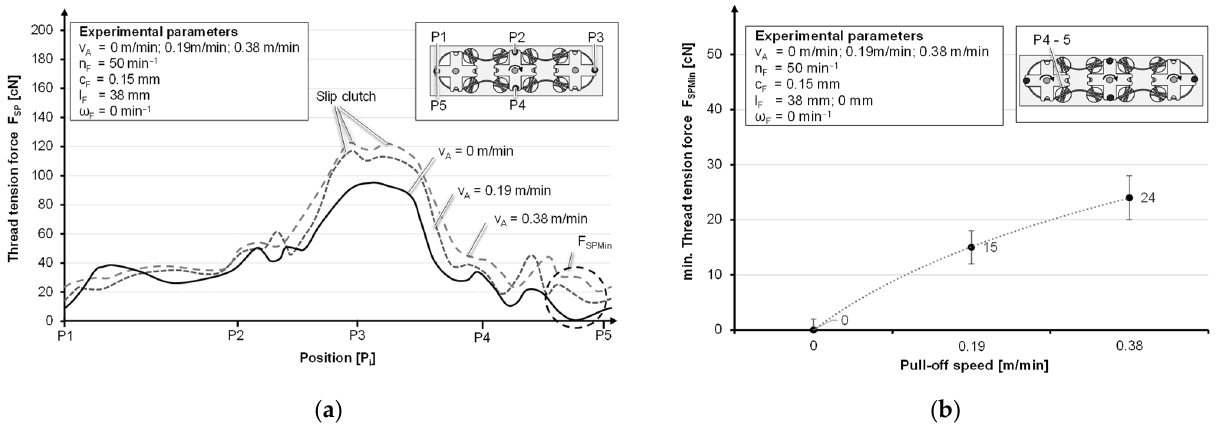
Figure 9. Thread tension curves at different haul-off speeds ( a ) and averaged minimum thread tension at different haul-off speeds ( b ).